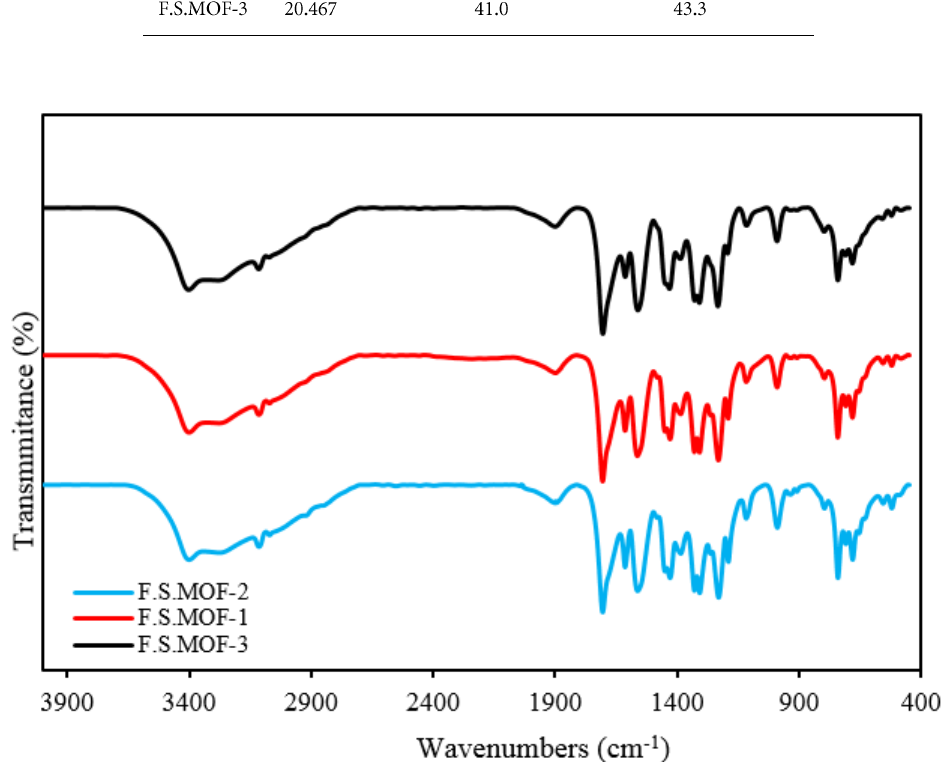
Fig. 5. FTIR analysis of magnetic metal-organic nanocomposites with different weight percentages of nickel